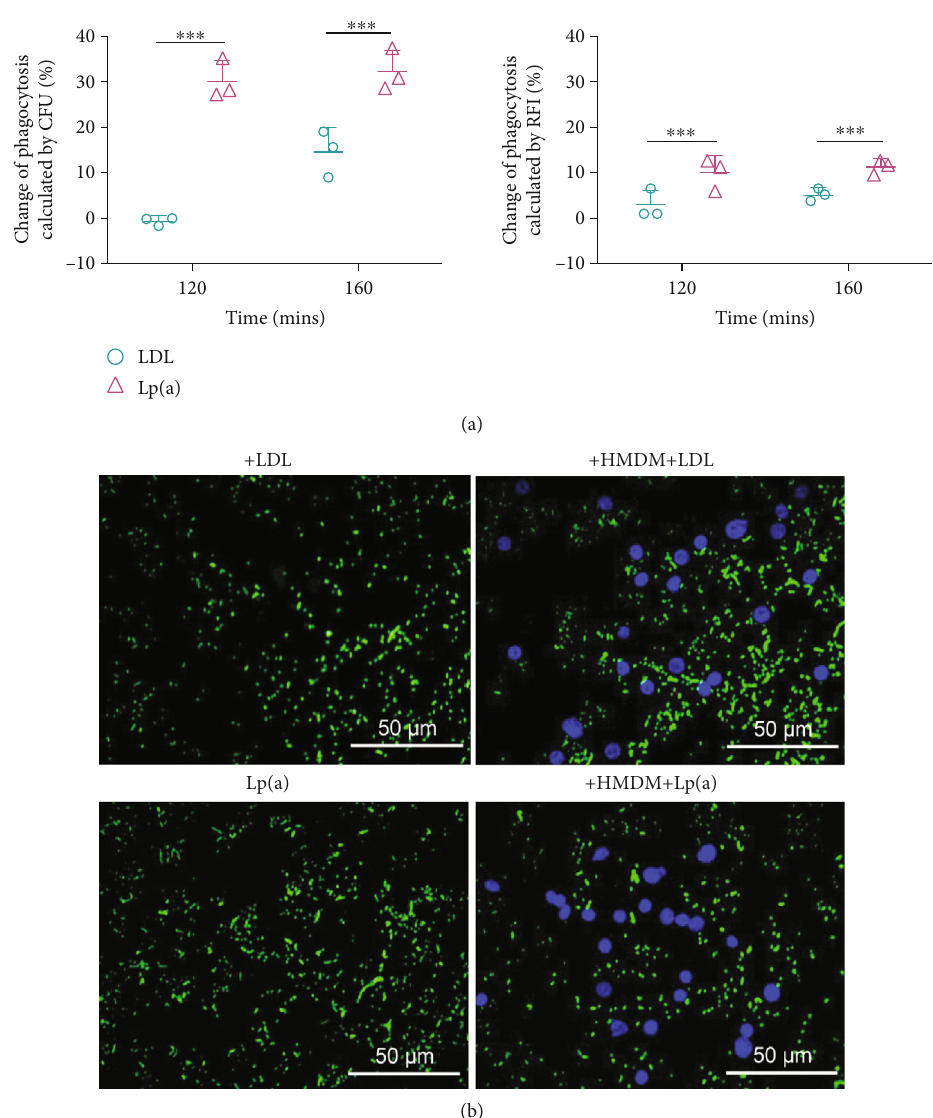
Figure 7: Lp(a) enhanced PBMC-derived macrophage phagocytosis of NTHi. The e ff ects of Lp(a) on PBMC-derived macrophage phagocytosis of NTHi were determined by (a) CFU counts, RFI measurements, and (b) fl uorescence micrographs. The MOI of NTHi49247 was 60 :1. Data are shown as the means ± SD from three independent experiments. Statistical signi fi cance of the di ff erences between groups was determined by two-way ANOVA with the Bonferroni post hoc test. ∗∗∗ P < 0 : 001